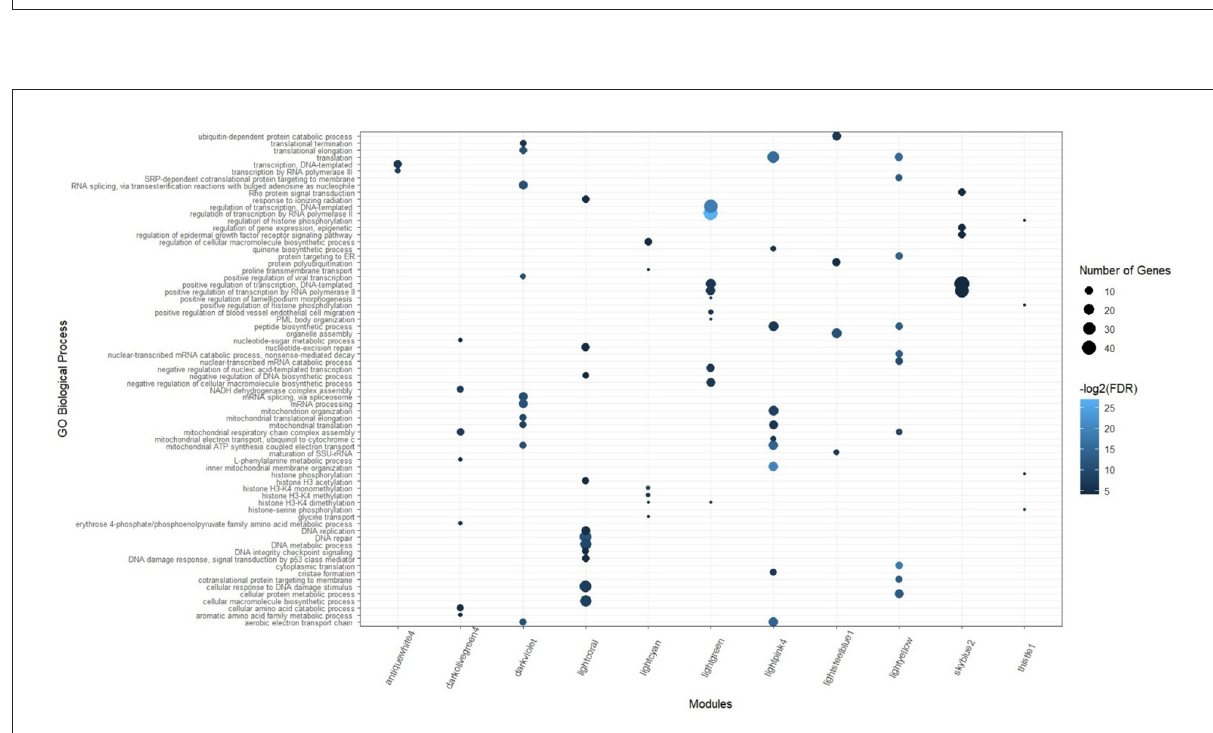
FIGURE5 Significant biological processes for the genes in the preserved consensus modules. Only top 10 terms were presented for darkviolet, lightpink4, and lightyellow modules, as they have a lot of significant